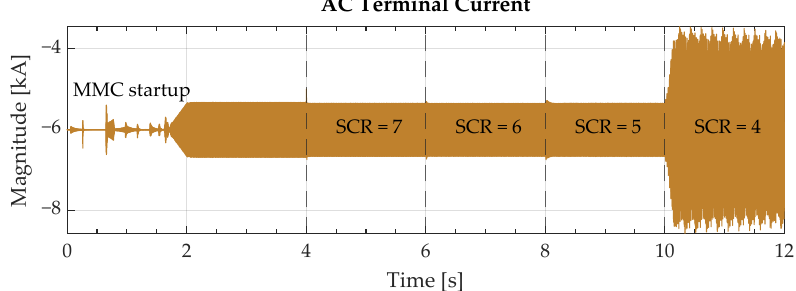
Figure 10. AC terminal current when MMC is connected to AC grids with decreasing SCR.